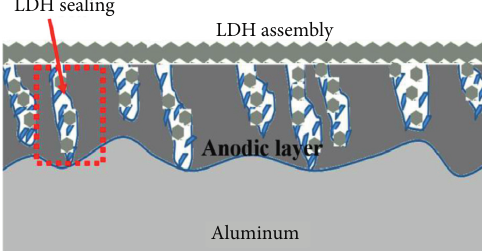
Figure 1: Schematic representation of LDH synthesis on the an- odized